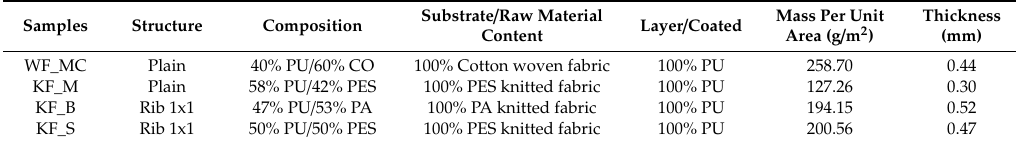
Table 1. Basic parameters of polyurethane coated